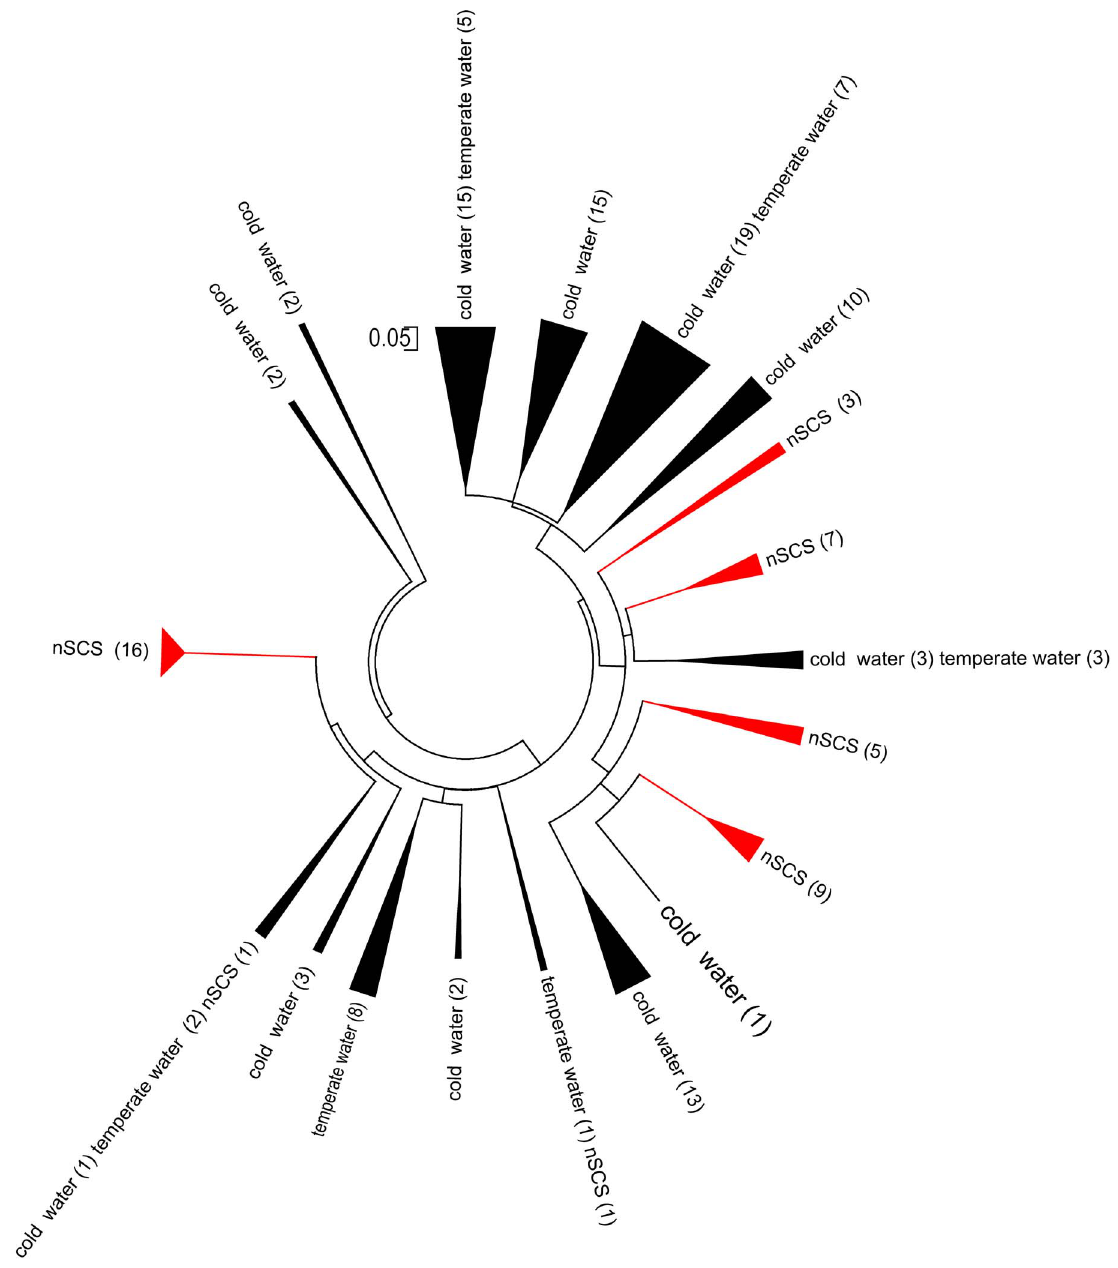
Figure 6. Biogeographic distribution of g5 gene OTUs in the nSCS (red) compared with those from Subartic North Atlantic Ocean (cold water), the Arctic Ocean (cold water) and Chesapeake Bay (temperate water).